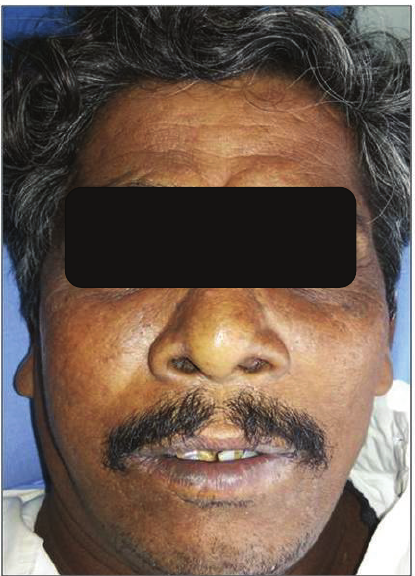
Figure1:Diffusefacialswellingandmildbilateralobliterationofthe nasolabial folds.